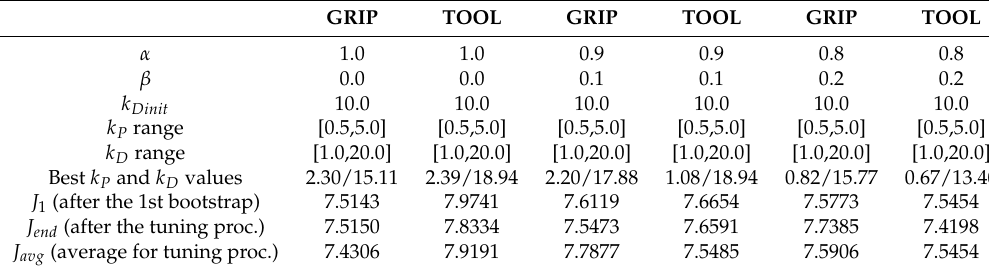
Table 6. Results of simulation experiments—flying with: gripper & jar (GRIP), and tool accessories (TOOL); for 2 bootstrap cycles, 56 iterations of the GLD method with low-pass filtration and (cid:101) =